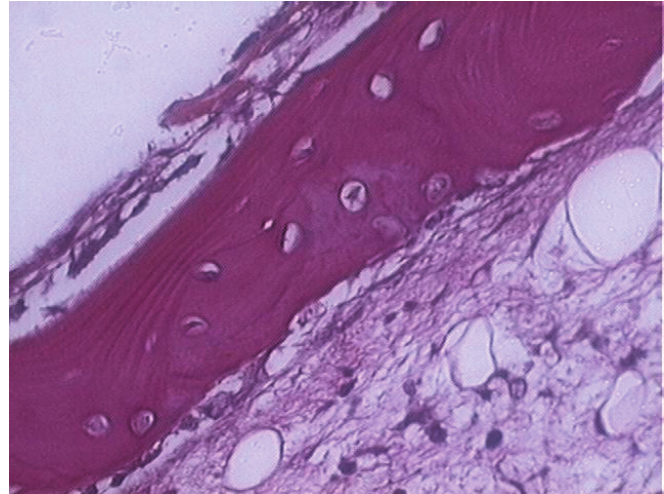
FIGURE 4 - Photomicrography showing the thickness of the new bone tissue around the